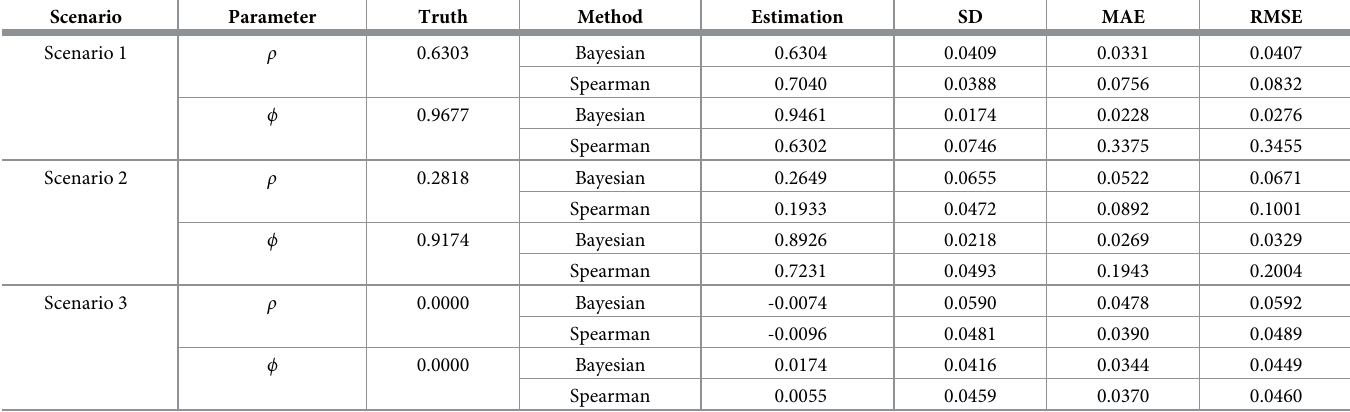
Table 3. Comparisons of the estimated correlations for latent log 2 MIC ( ρ ) and binary classification ( ϕ ) between the Bayesian and Spearman method through